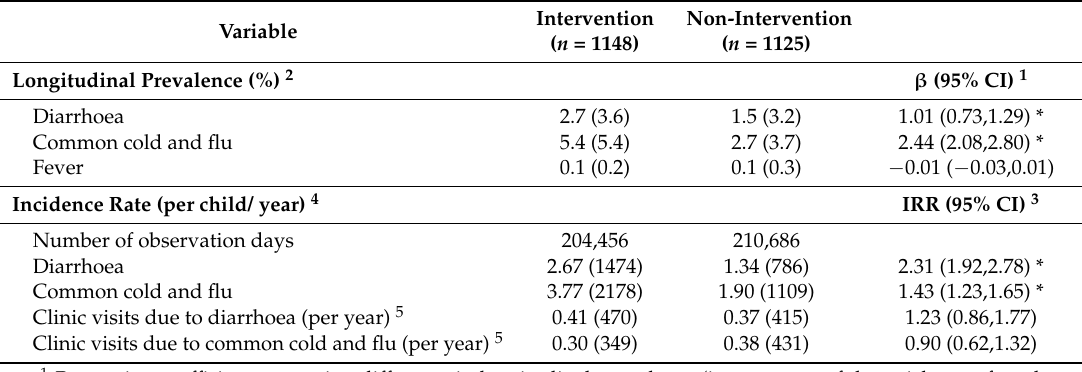
Table 4. Prevalence and incidence of diarrhoea, common cold and flu, and fever during the intervention